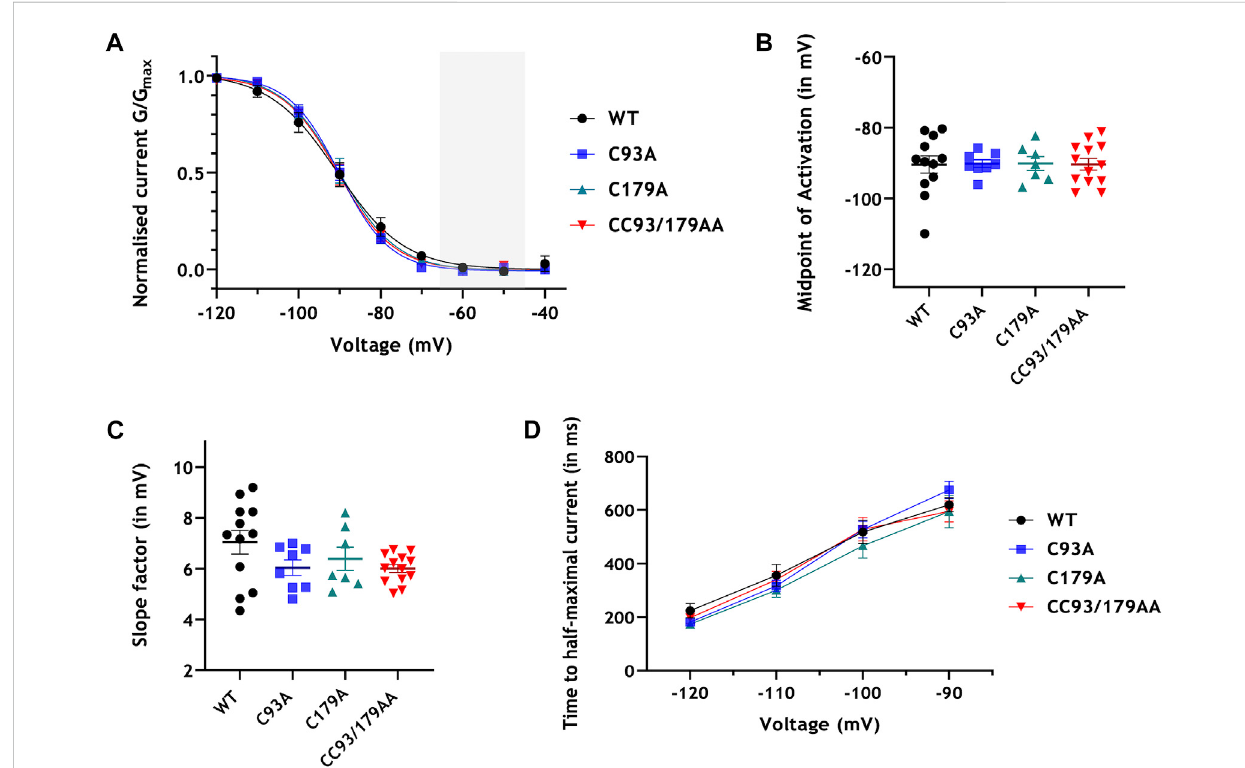
Palmitoylation and HCN4 currents: analysis. (A) Whole cell channel conductance (G) was normalised to the maximum conductance (G max ) of each celland fi ttedwithaBoltzmannfunction.Thesinoatrialdiastolicdepolarisationvoltagerangeishighlightedingrey. (B) Half-maximalactivationpotentials (V 0.5 )obtained from the Boltzmann fi ts of theactivation curvesfor each cell. (C) Slope factor (k) obtained from theBoltzmann fi tsof the activation curves for each cell. (D) Time to half-maximal activation at voltages − 90 mV to − 120 mV. No groups are signi fi cantly different from each other; n =